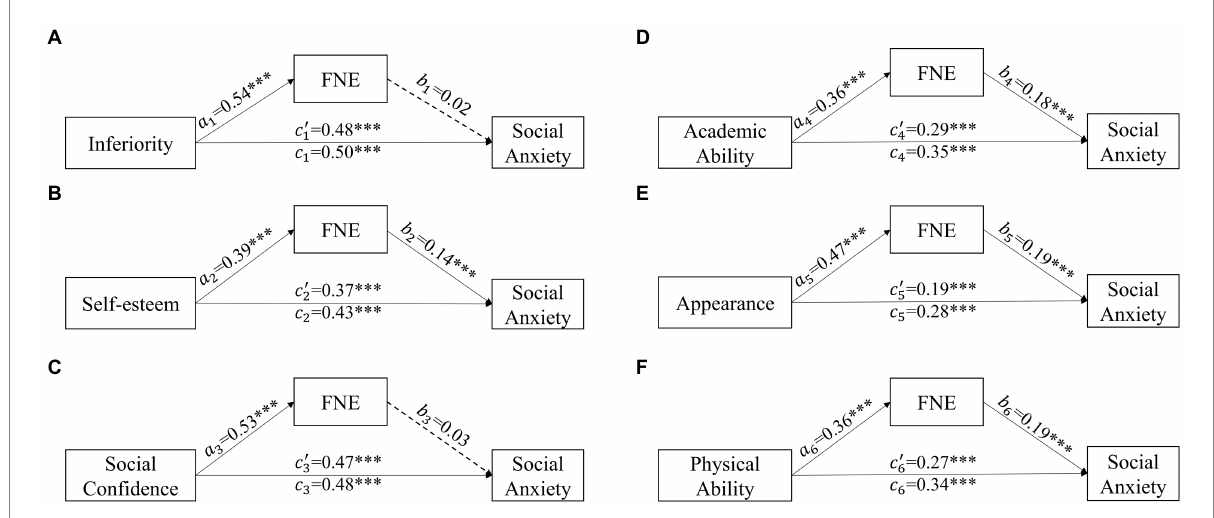
FIGURE 2 The mediation model of fear of negative evaluation on the relationship between inferiority and social